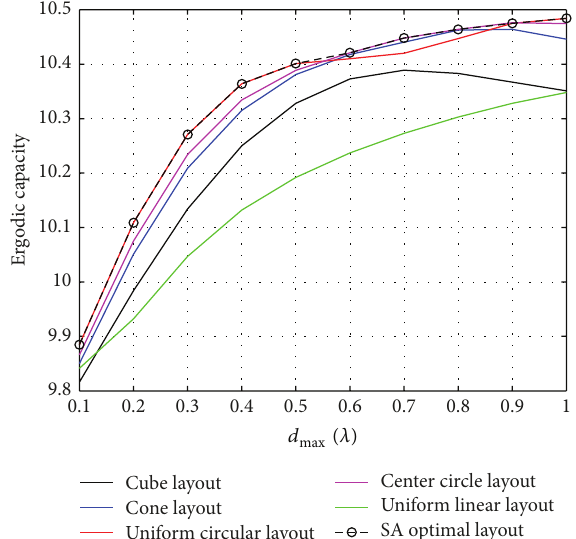
Figure 6: Capacity difference between the layout in Figure 5(b) and the corresponding center-circle layout. 𝛾 0 = 20 dB. Figure 7: Capacity difference between the optimal layout and the reference regular layouts for Scenario II. 𝛾 0 = 20